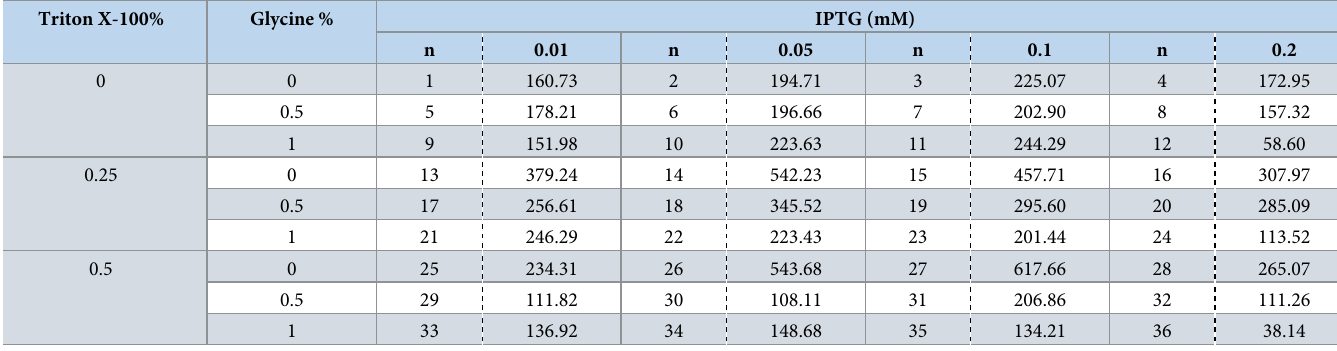
Table 1. The amount of the rPF4 protein secreted in the fractional factorial experiment ( μ g/mL). Triton X-100% Glycine